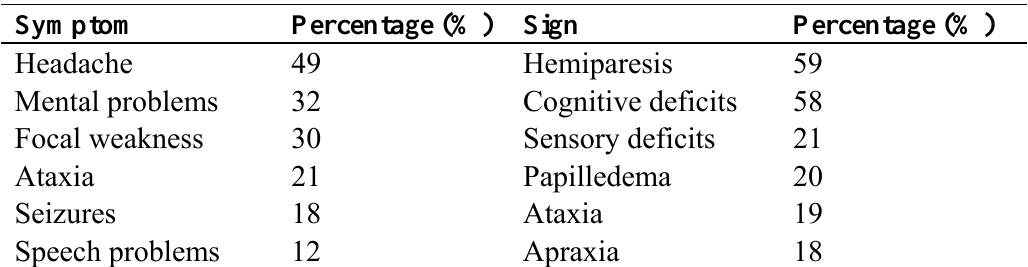
Table 1. Clinical presentation of brain